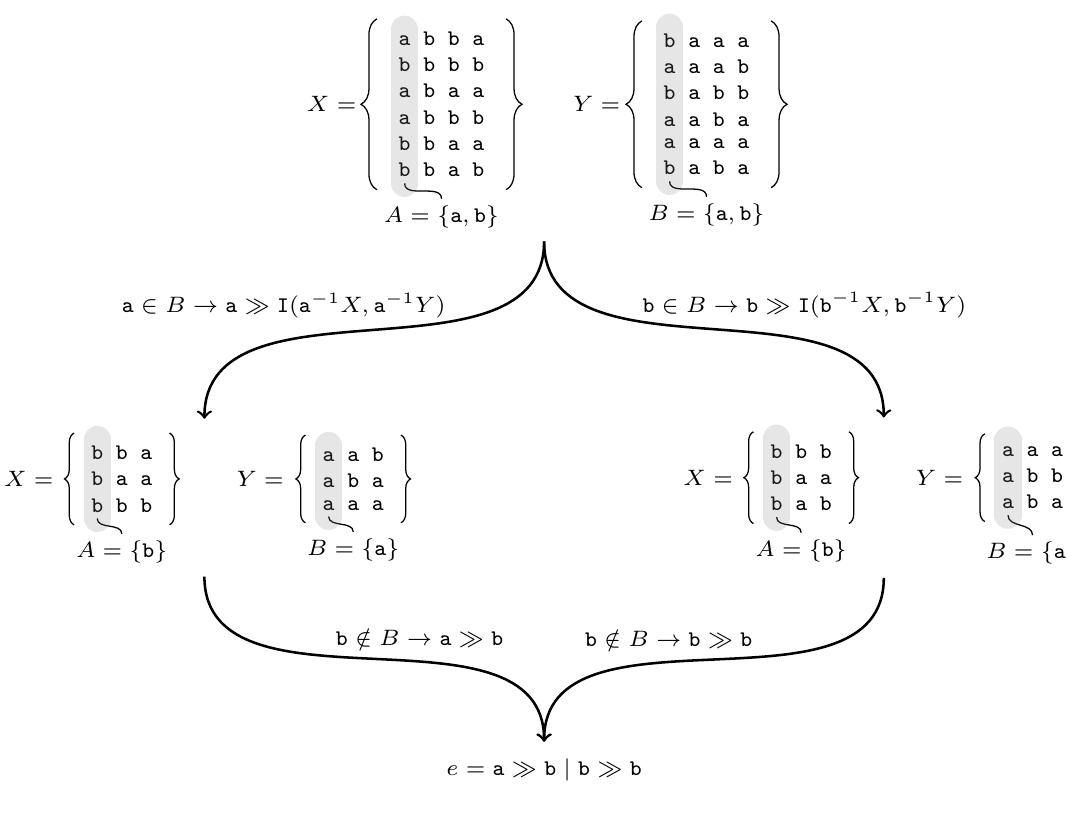
Figure 2. Example of the proposed Induction